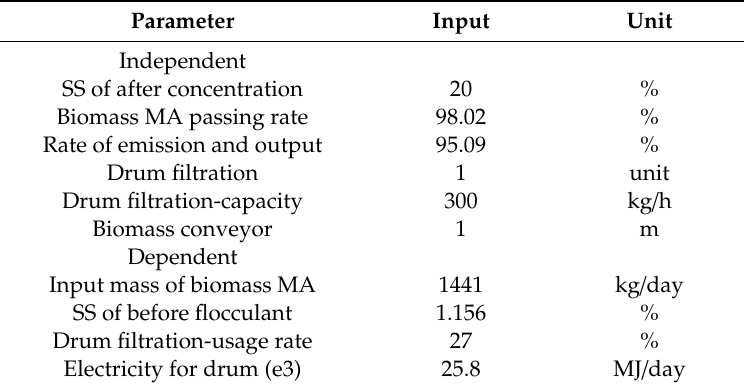
Figure 8. Mass balance of microalgae oil production in drum filtration sub-unit per 1 m 3 . Table 7. Parameters set at filtration sub-unit per 50 m 3 / day.